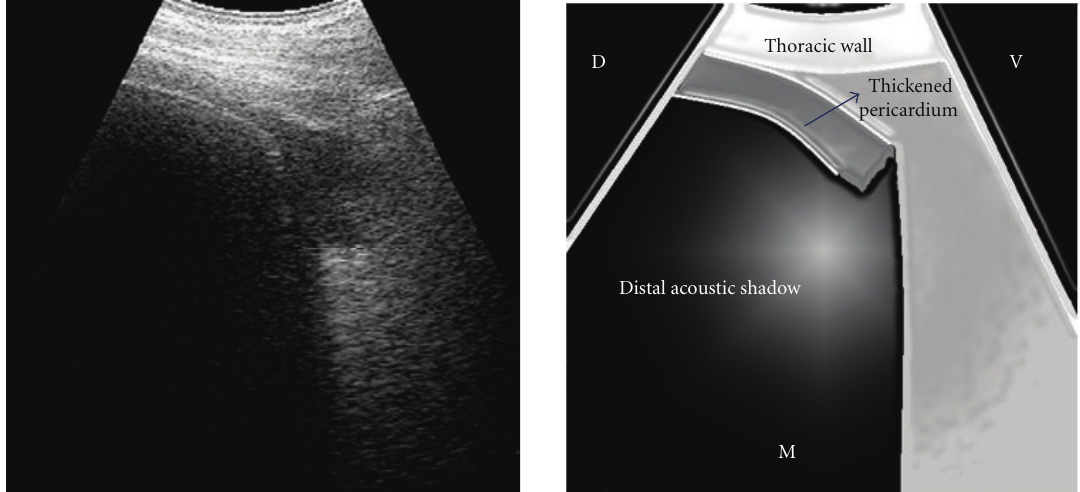
Figure 7: Two-dimensional echocardiogram obtained from the right 4th ICS, showing thickened pericardium with distal acoustic shadow. ICS: intercostal space; D: dorsal; V: ventral; M: medial.